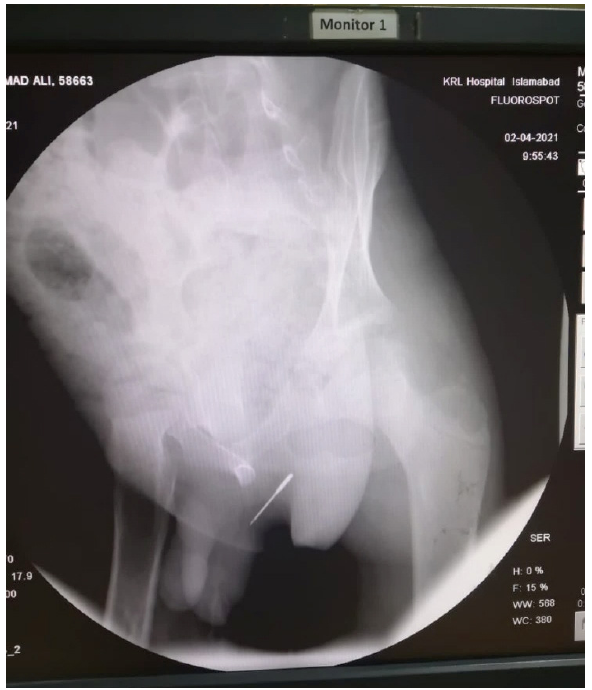
Figure 2: Plain X-ray showing opaque foreign